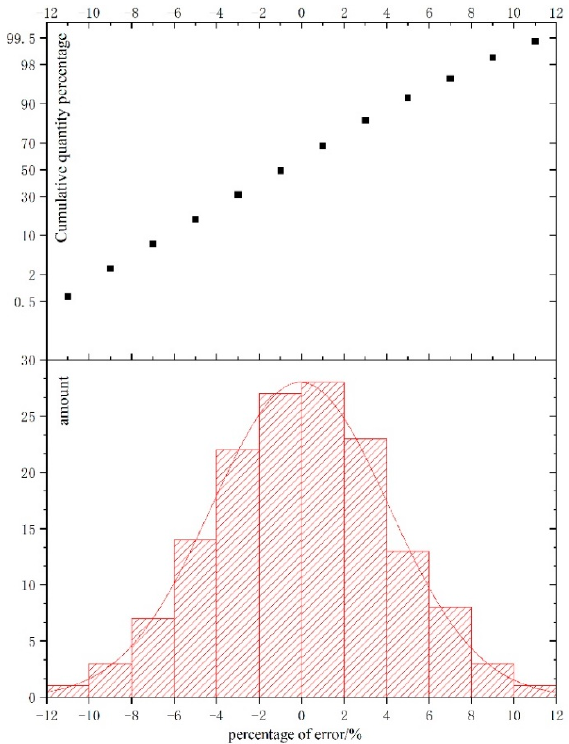
Figure 6. Errors between the measurement and analysis of cable force.